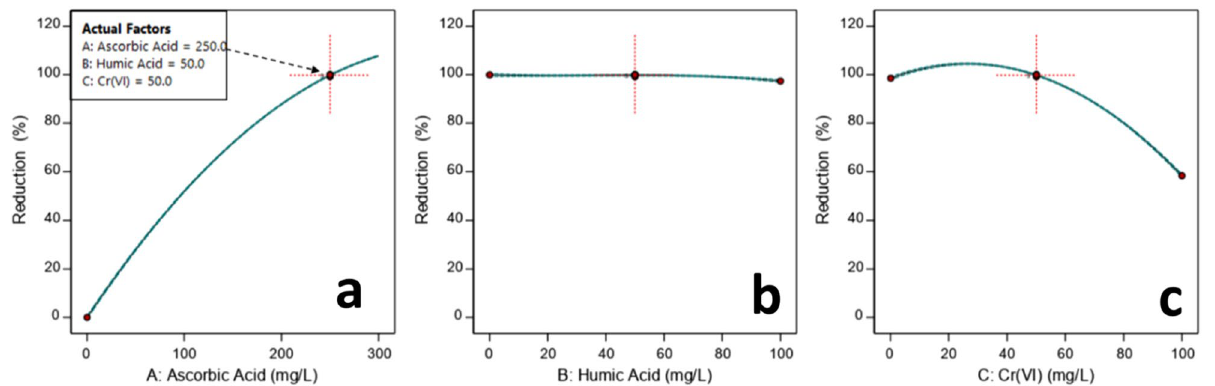
Figure 4. Effect of ascorbic acid, humic acid, and initial chromium concentration on the reduction of Cr(VI) in aqueous